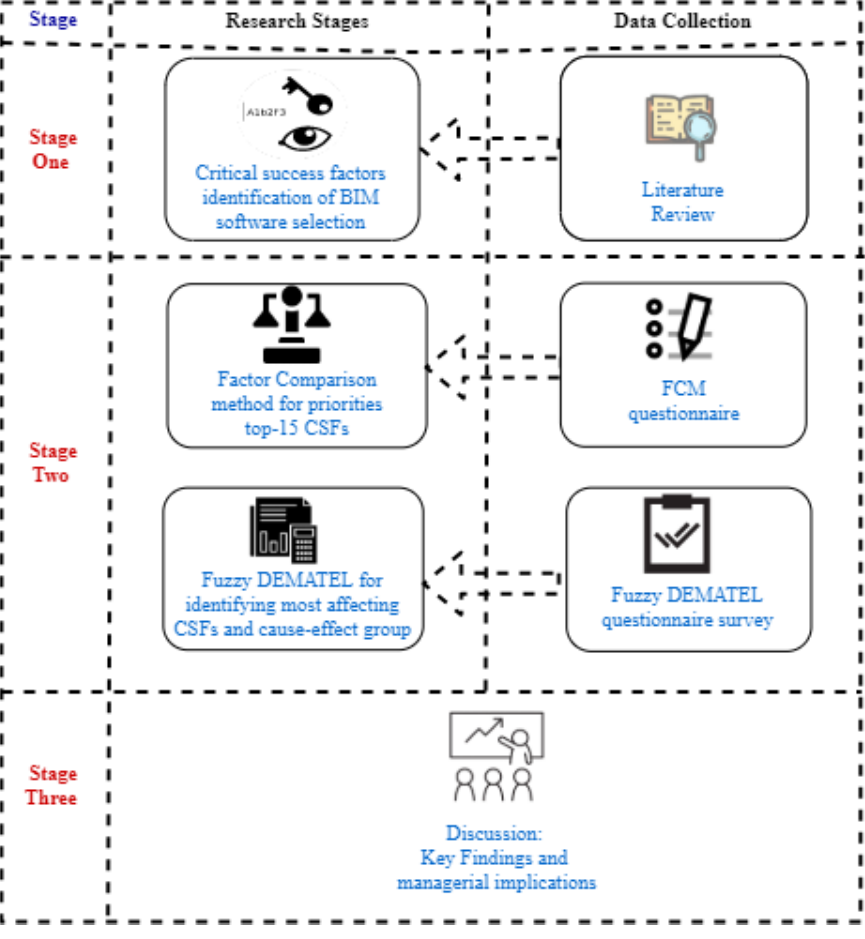
Figure 1. Research process.